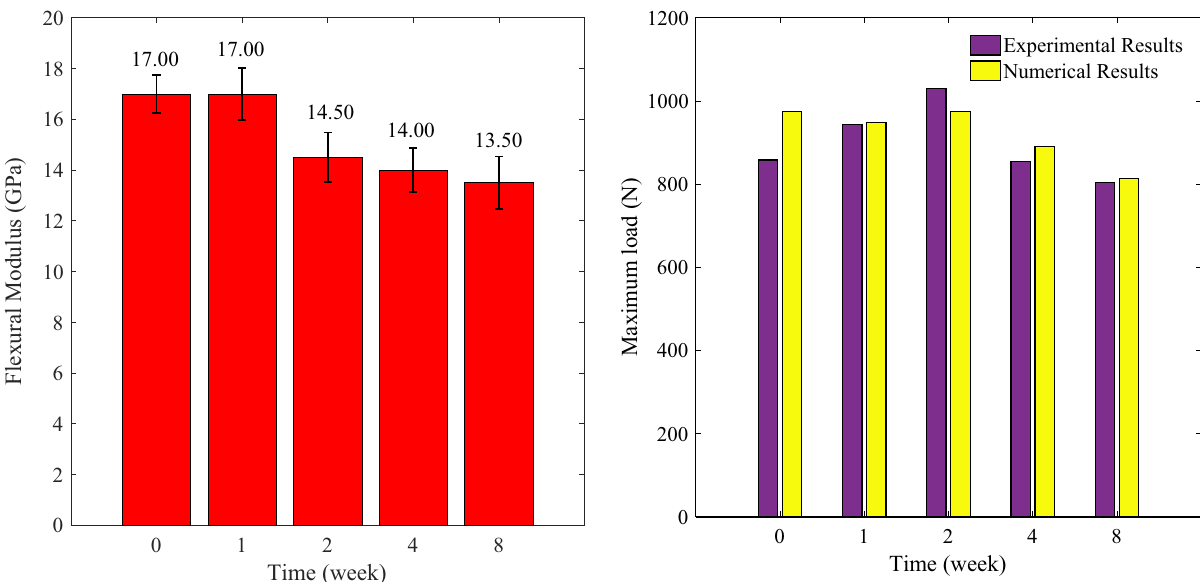
Figure 13: Comparison of the maximum experimental and predicted loads for samples exposed to an acidic environment at